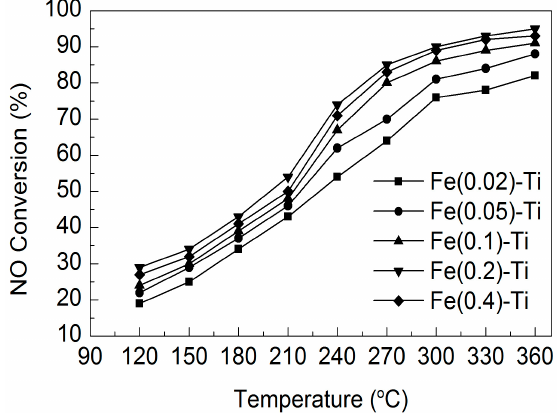
Figure 1. NO conversion over various Fe–Ti catalysts. Reaction conditions: [NO] = [NH 3 ] = 500 ppm, [O 2 ] = 5 vol. %, N 2 balance, and gas hourly space velocity (GHSV) = 90,000 h − 1 .